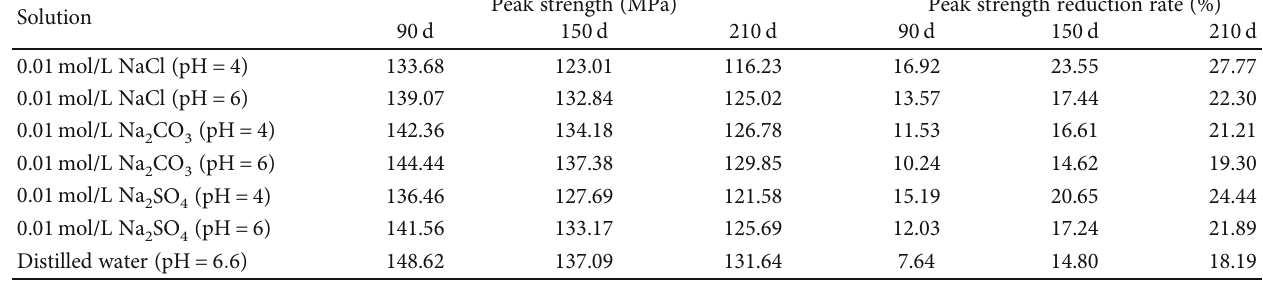
Table 4: Peak strength of limestone under coupled MC e ff ects in uniaxial compression tests.